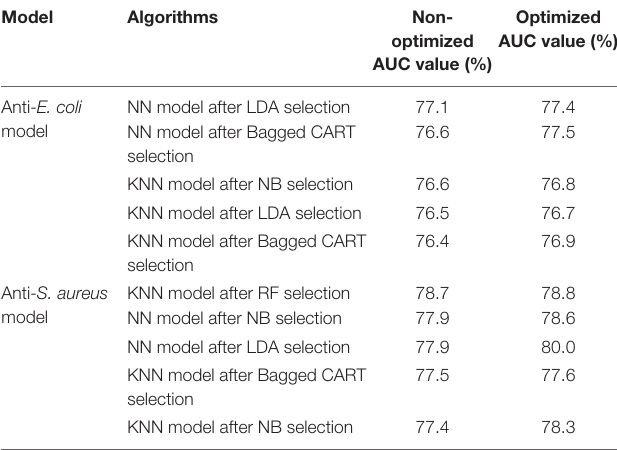
TABLE 1 | AUC value optimization of antibacterial activity prediction models. Model